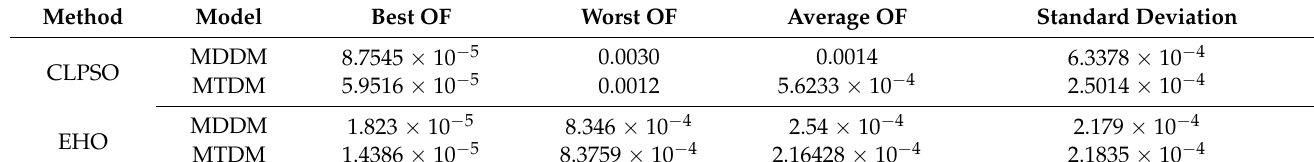
Table 3. Statistical analysis for MDDM and MTDM by CLPSO and EHO algorithms for Q6-1380 solar cell at irradiance level (9.84 mW/cm 2 ) and room temperature (300 K).